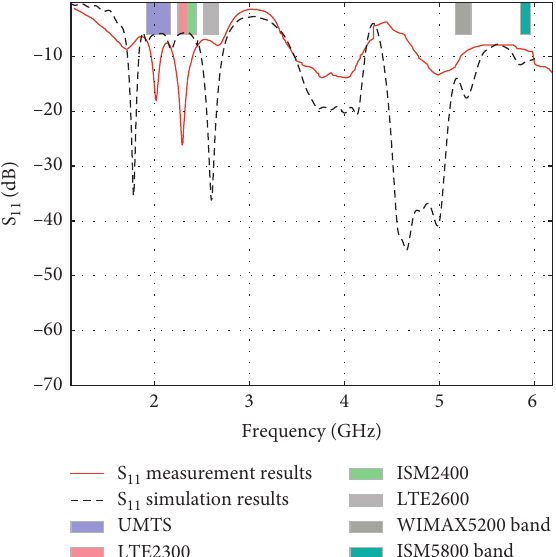
Figure 7: S 11 simulation vs measurement results.